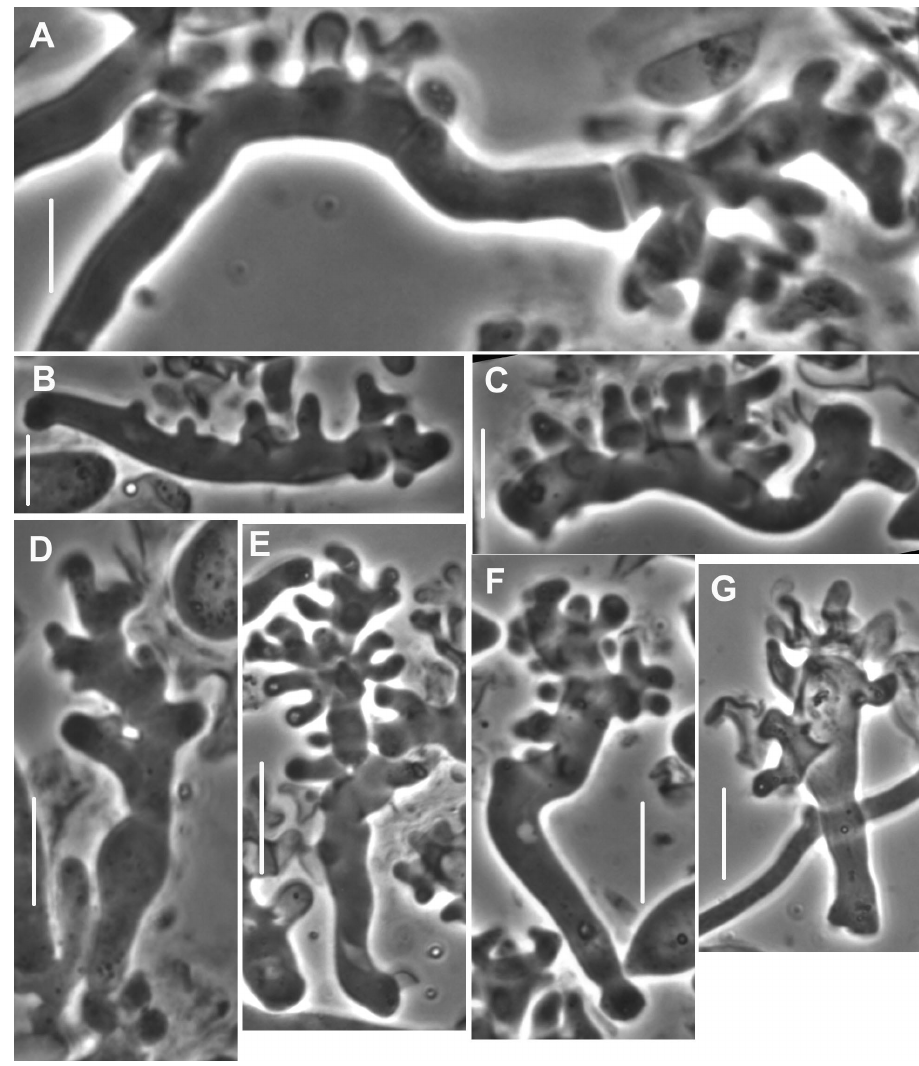
Figure 52. Mycetinis opacus . Pileipellis elements. A–C Diverticulate hyphae. D–G Broom cell-like pileo- cystidia. Standard bars = 10 µm.